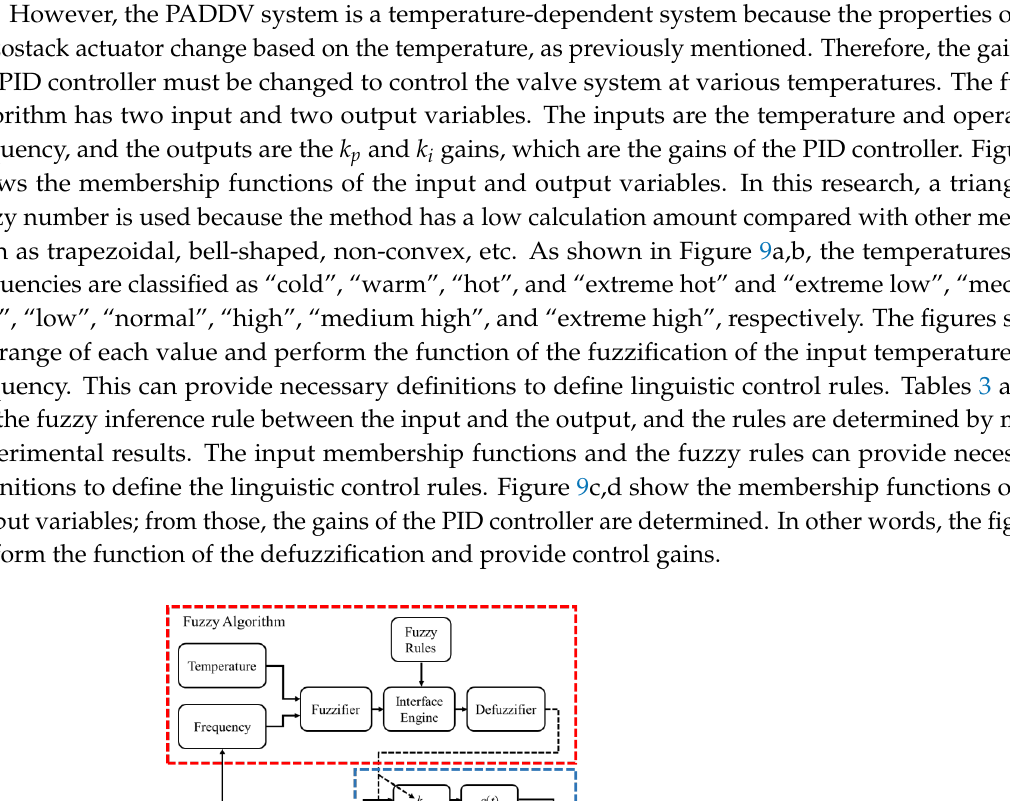
Table 4. Fuzzy rules for I gain ( k i ).